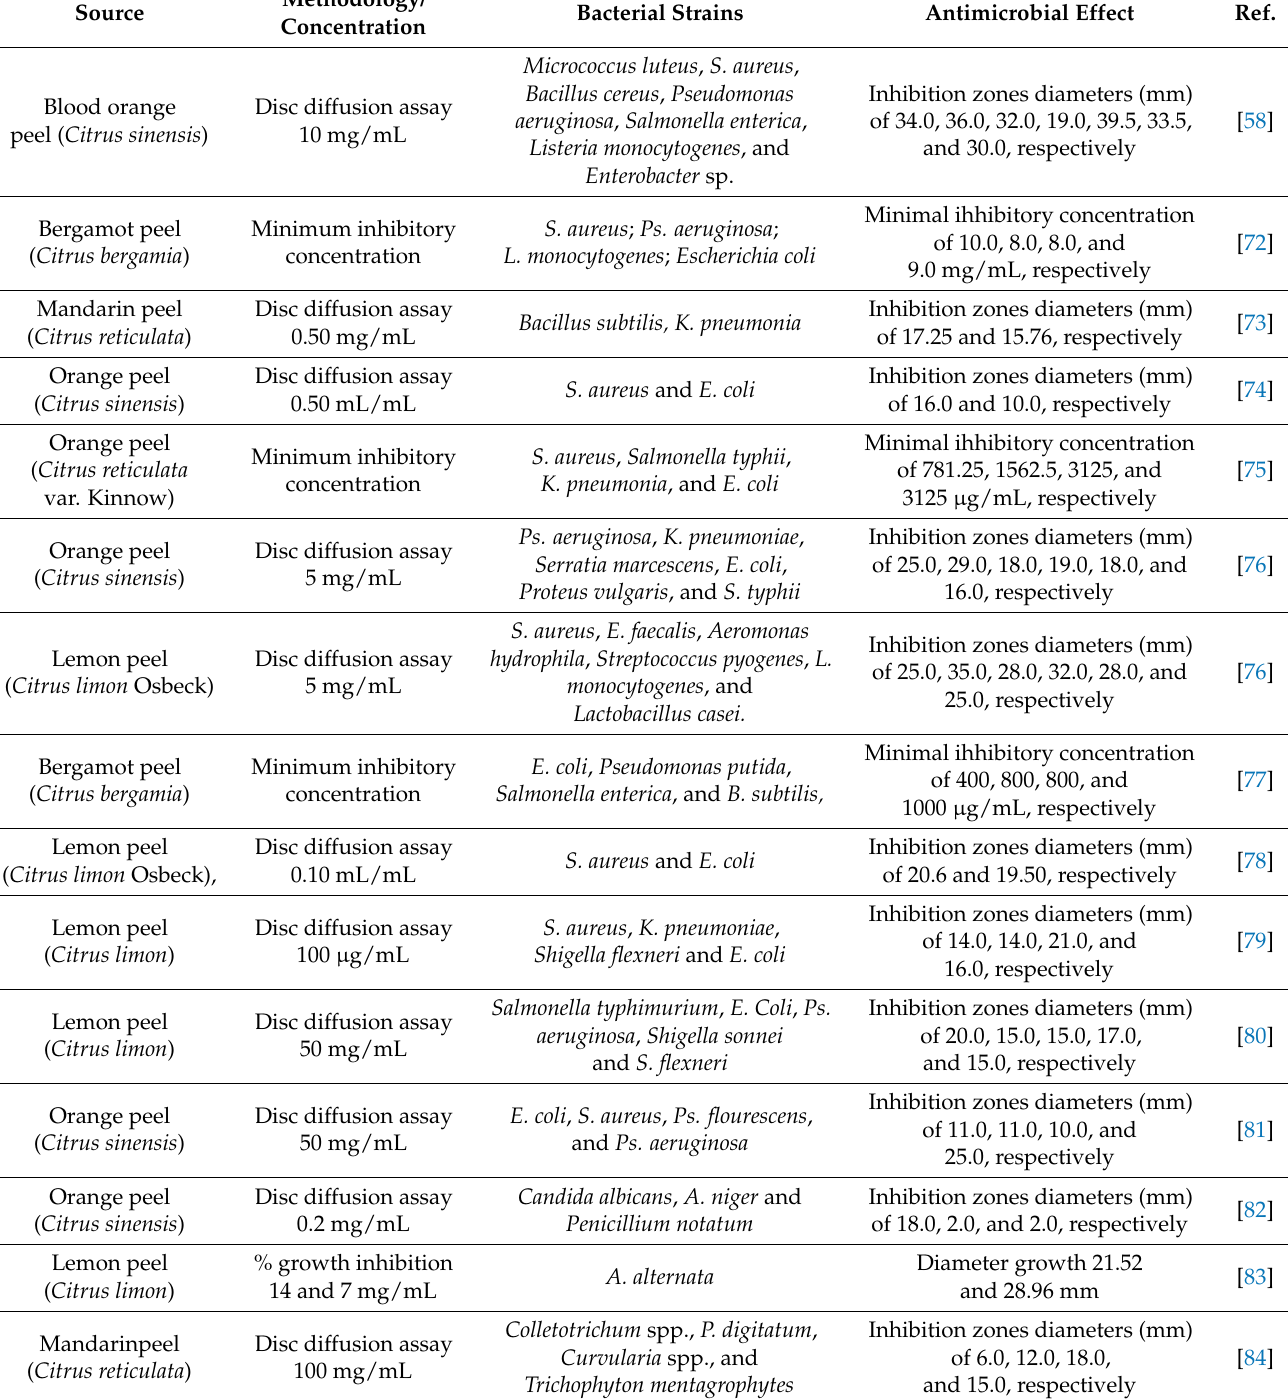
Table 2. Antibacterial activity of peel extracts obtained from different Citrus